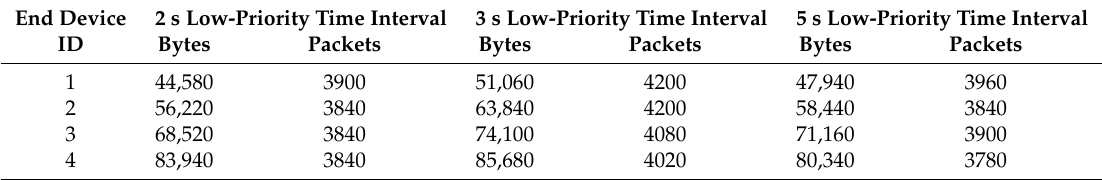
Table 5. Number of processed bytes in the EEMIP mode during a congestion with each 3rd packet lost. End Device